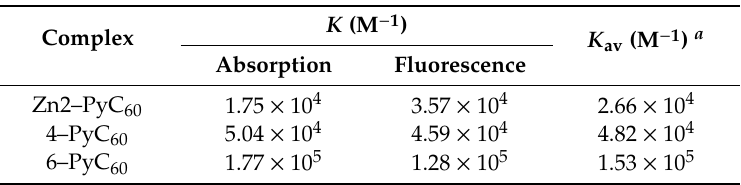
Table 1. Binding constants ( K , M − 1 ) calculated by absorption and fluorescence measurements